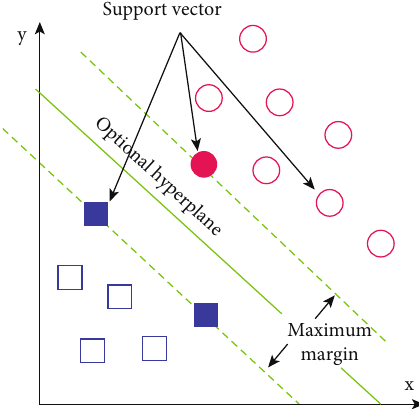
Figure 5: Support vector